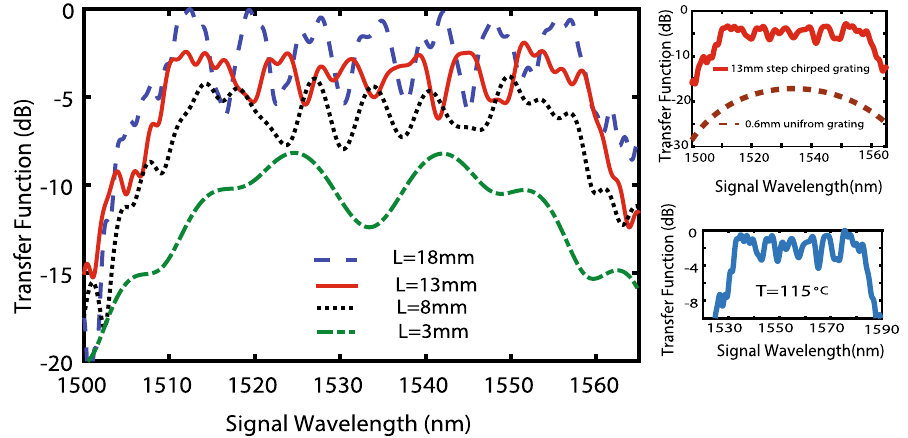
Figure 1. ( a ) Normalized transfer functions with bandwidths as large as 50 nm for different lengths of SC- PPLN at 25 °C, considering input pump (plane wave) at a wavelength of 1550 nm and a sweeping control signal. Longer nonlinear crystal introduces larger ripples while the up-conversion peak power increases. Therefore, there is a trade-off between the acceptable ripple height and the generated power, for the choice of length. ( b ) Equal-bandwidth transfer functions of a 0.6 mm-long uniform PPLN and a 13 mm long SC-PPLN are compared. ( c ) Transfer function for the compromised length (13 mm) at 115 °C still covers the C